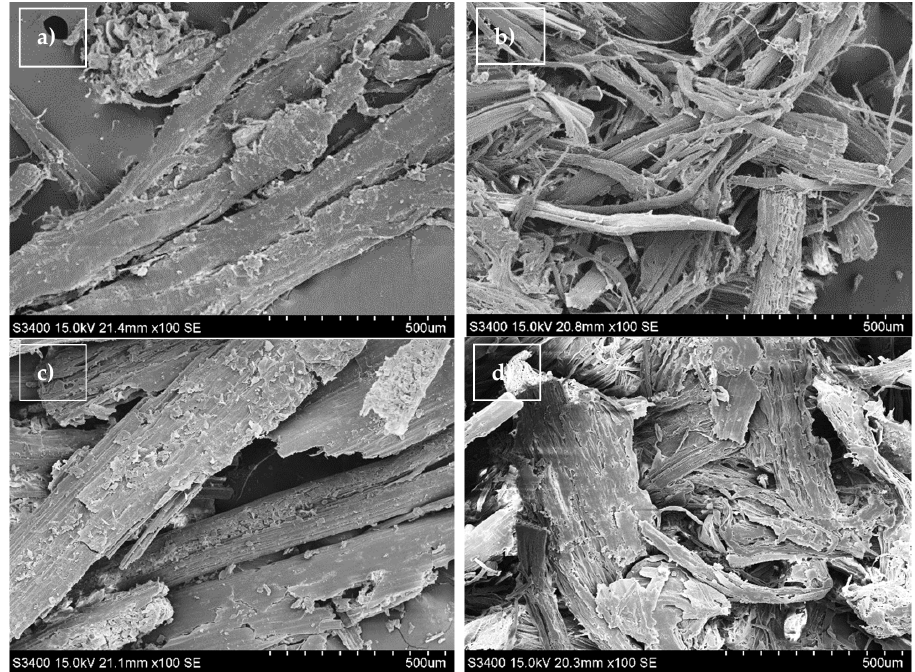
Figure 2. SEM images of halophyte biomass: ( a ) hemp biomass before NaOH pretreatment, ( b ) hemp biomass after NaOH pretreatment, ( c ) grass biomass before NaOH pretreatment, ( d ) grass biomass after NaOH pretreatment.